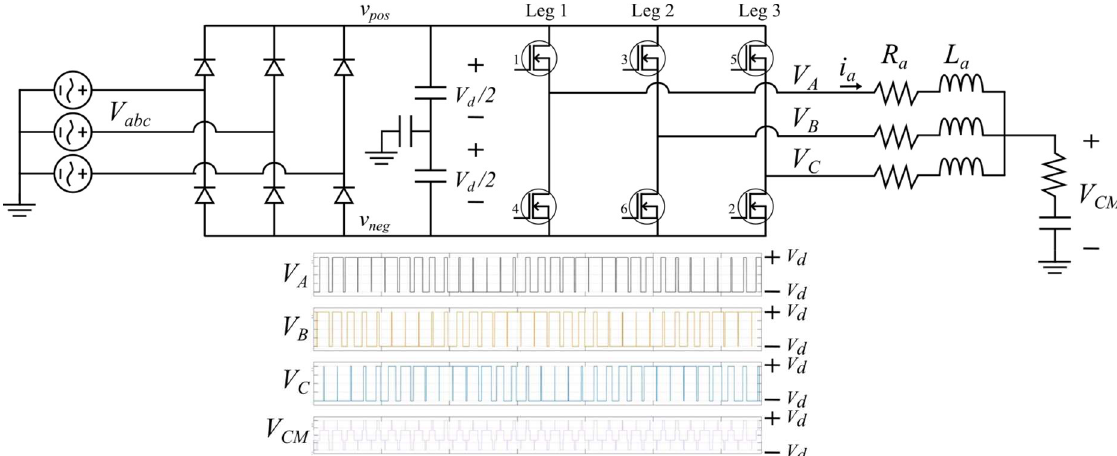
Figure 2. A typical three-phase ac-dc-ac motor drive power electronic converter for lower power applications (<25 hp). The ac grid input voltages are converted to dc via a three-phase diode bridge rectifier. A two-level six-switch inverter then synthesizes the dc bus into the PWM phase voltages necessary to drive the machine, which is depicted with a low frequency RL model. The inverter CM voltage is a result of the PWM phase voltages.